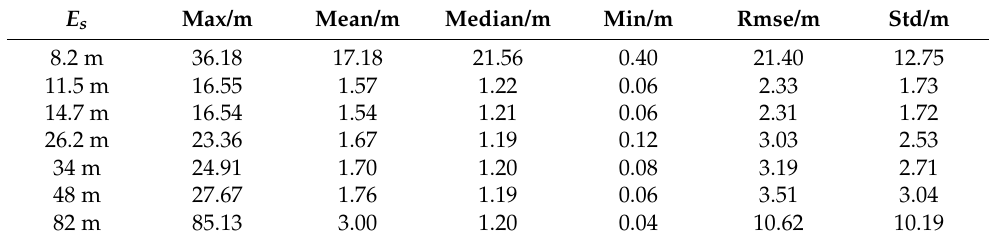
Table 4. Error parameters of the different localization verification thresholds of inducing